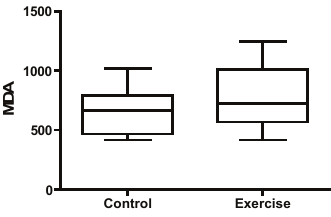
FIGURE 2 - Comparison of levels of MDA (ng/mL) in smooth muscle between groups (Student t test;